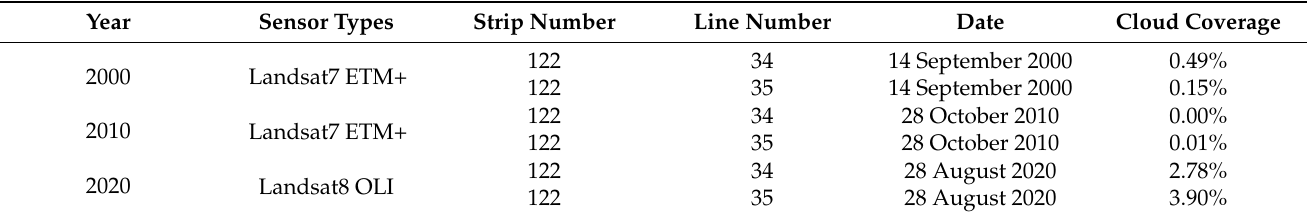
Table 1. Parameter information of Landsat